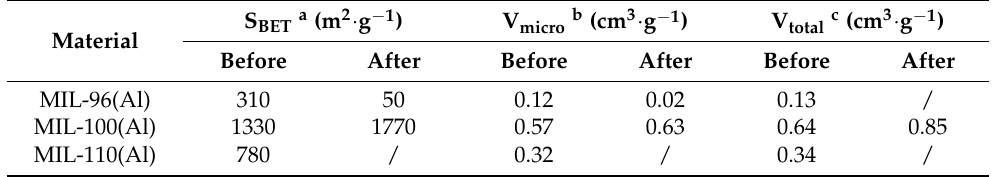
Table 2. BET surface area, micropore and total pore volume of samples before and after water 40-cycling treatment obtained from N 2 adsorption at 77